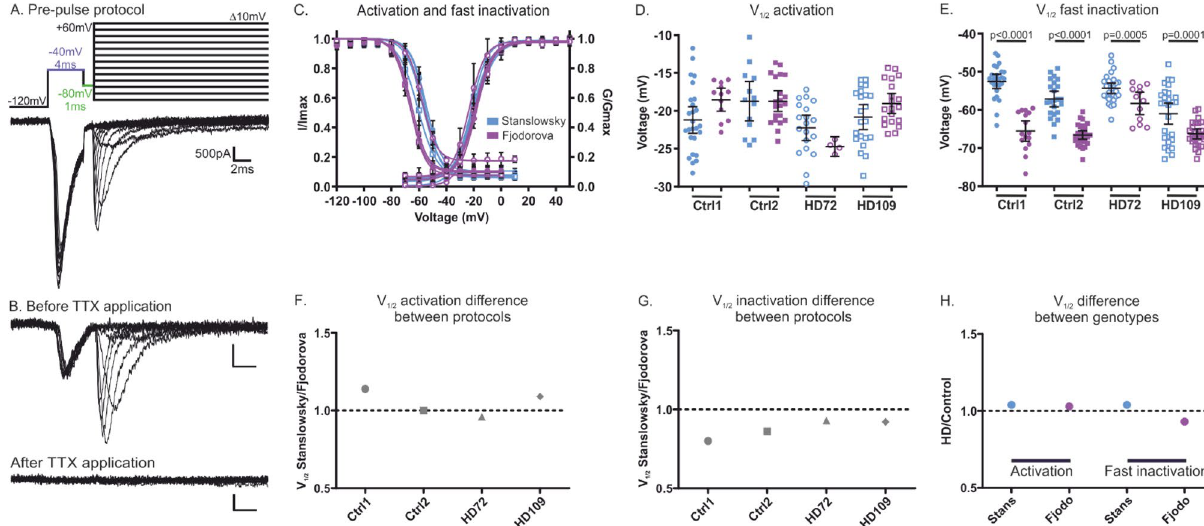
Figure 6. The two protocols reveal large differences in the gating properties of Nav channels expressed in the differentiated neurons. ( A ) Pre-pulse protocol (top) designed to accurately record voltage dependence of activation in mature hiPS cell-derived neurons without space clamp artefacts. Pre-pulse (purple) and inter- pulse (green) are adjusted to each neuron individually. Example trace (bottom) is from Ctrl2 neurons of the Fjodorova protocol. ( B ) Representative recording of HD72 hiPS cell-derived central neurons of the Stanslowsky protocol before 500 nM TTX application (top) and following 500 nM TTX application (bottom). Scale bars are the same as in ( A ). ( C ) Voltage dependence of activation and steady-state fast inactivation of control and HD neurons of the Stanslowsky protocol (blue) and of the Fjodorova protocol (purple) (see Table S8 for results of each individual cell line). ( D - E ) Values for half-maximal (V half ) voltage-dependent activation ( D ) and steady- state fast inactivation ( E ) of Ctrl1 (filled circles, n = 24–26), Ctrl2 (filled squares, n = 13–23), HD72 (open circles, n = 19–30) and HD109 neurons (open squares, n = 20–22) for the Stanslowsky protocol and Ctrl1 (filled circles, n = 12–16), Ctrl2 (filled squares, n = 21–27), HD72 (open circles, n = 12–30) and HD109 neurons (open squares, n = 20–26) for the Fjodorova protocol. Data show mean ± 95% CI. ( F – H ) Plot displays the difference between V half values of voltage dependence of activation ( D ) and steady-state fast inactivation ( E ) obtained from the two differentiation protocols when control/HD neurons of each protocol are pooled. A value of 1 (dotted line) represents equal V half values in both protocols. Values < 1 mean hyperpolarized values in the Fjodorova protocol as compared to the Stanslowsky protocol. While both protocols provide comparable values for voltage dependence of activation ( F ), neurons from the Fjodorova protocol consistently display a hyperpolarized fast inactivation ( G ). ( H ) Plot displays the difference between V half values of voltage dependence of activation and steady-state fast inactivation obtained from the two genotypes for each protocol. The genotype does not seem to influence the Nav channel gating of hiPS cell-derived cell-derived HD72 neurons (Fig. 6B) and we assumed that all the Nav isoforms expressed in our neurons are TTX-sensitive. These voltage-clamp results are well in line with the RT-qPCR results (Fig. 5), suggesting that the cells revealed by the differentiation protocols are indeed of CNS lineage. The iPS cell-derived neurons from each protocol showed a similar current density (Supplementary Table S8). Concerning the voltage dependence of activation, a large variability in the half maximal voltage was observed between the neurons of each protocol, and no significant difference was found. This suggests that the protocols do not exert any obvious effect on the activation of the Navs expressed in the differentiated neurons (Fig. 6C-D and Table S8). We found a more depolarized half maximal voltage in all four differentiated neurons from the Stanslowsky protocol (V half = − 52.5 mV (CI − 54.4 to − 50.7 mV) for the Ctrl1 to − 61.0 mV (CI − 63.7 to − 58.2 mV) for the HD109 neurons) compared to those of the Fjodorova protocol (V half = − 58.3 mV (CI − 61.2 to − 55.3 mV) for the HD72 neurons to − 66.6 mV (CI − 67.5 to − 65.5 mV) for the Ctrl2) (Fig. 6C,E and Table S8). The plots displaying the differences between V half values of activation (Fig. 6F) and V half of fast inactivation (Fig. 6G) sum up the discrepancy within the two protocols observed in the previous panels of Fig. 6, while they